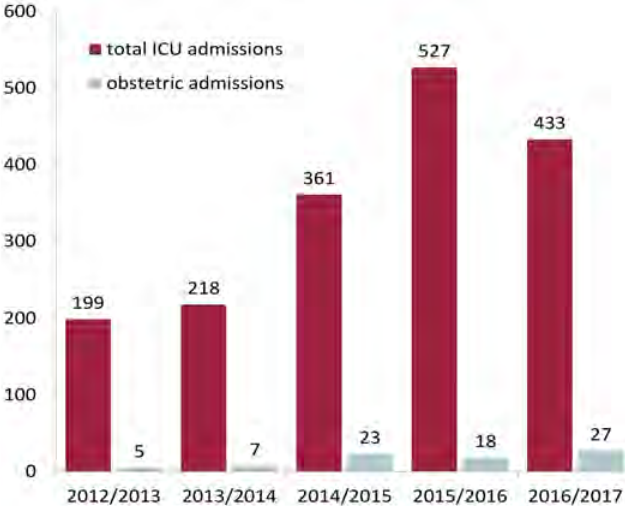
Fig 1 : Temporal trend of ICU